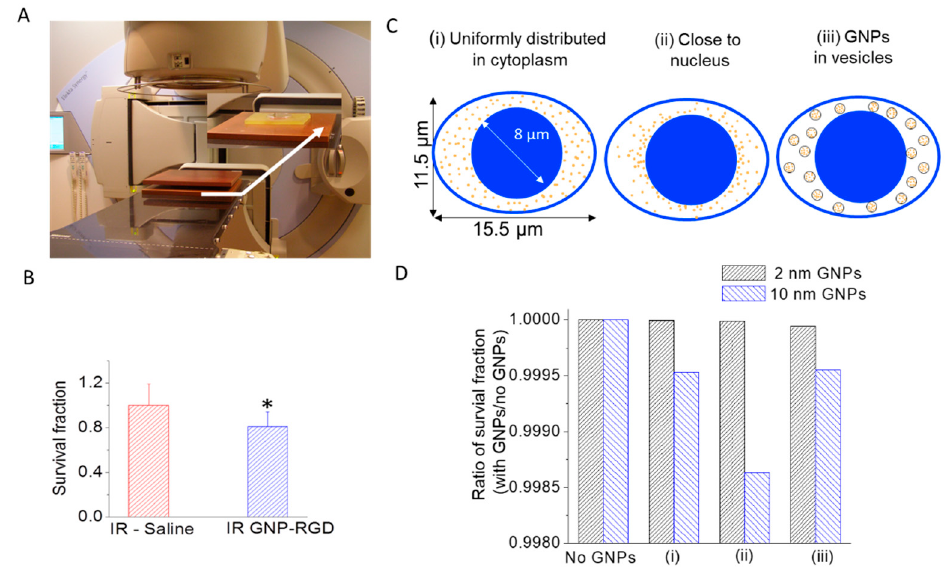
Figure 4. ( A ) Setup of irradiation experiment; ( B ) Cell survival fraction of MDA-MB-231 cells treated with saline (control) and GNP-RGD) (Gold nanoparticles modified with a peptide containing Arg-Gly-Asp tripeptide sequence (RGD)) prior to 2 Gy, 6 MV X-ray radiation. Data are means ± S.E.M. for n = 3. * represents statistically significant difference (unpaired t -test, p < 0.05); ( C ) Schematic of cell geometry and GNP distributions used in the Monte Carlo simulation based effect modeling; ( D ) The estimated reduction in survival fraction when using 2 nm and 10 nm GNPs with 367,000 GNPs internalized in the cell.